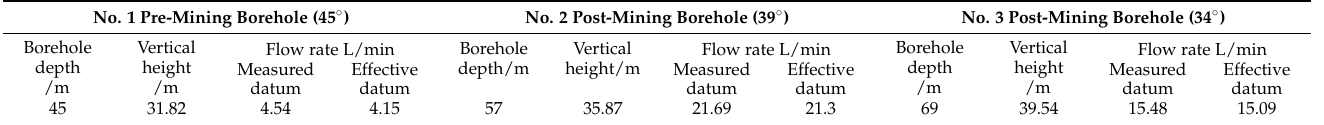
Table 5. Underground borehole observation data and effective leakage rates.